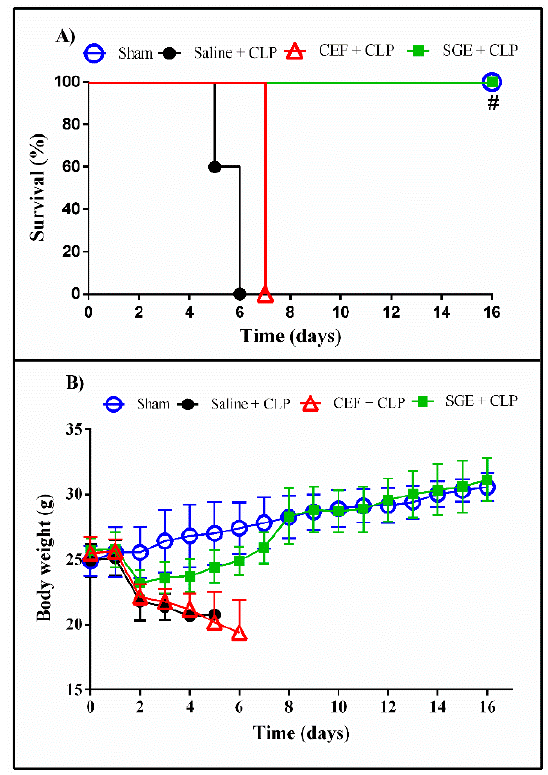
Figure 2. Effect of SGE on survival rate (%) and body weight (g) of septic mice within 16 days. ( A ) Survival of CLP animals pretreated with SGE (3.5 µ g/animal), CEF (20 mg/kg), or saline. ( B ) Body weight during time evaluated for survival. Data presented as mean ± SD ( n = 5). Kaplan–Meier analysis (# p < 0.005 CLP versus CLP + saline). CEF: ceftriaxone; CLP: cecal ligation and puncture SGE: salivary gland extract.